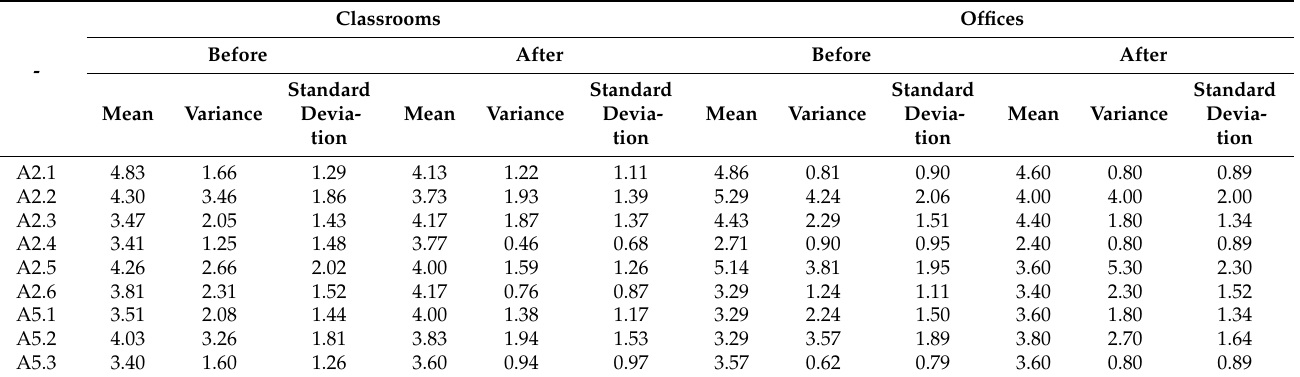
Table 8. Descriptive statistics for IEQ responses in John Laing